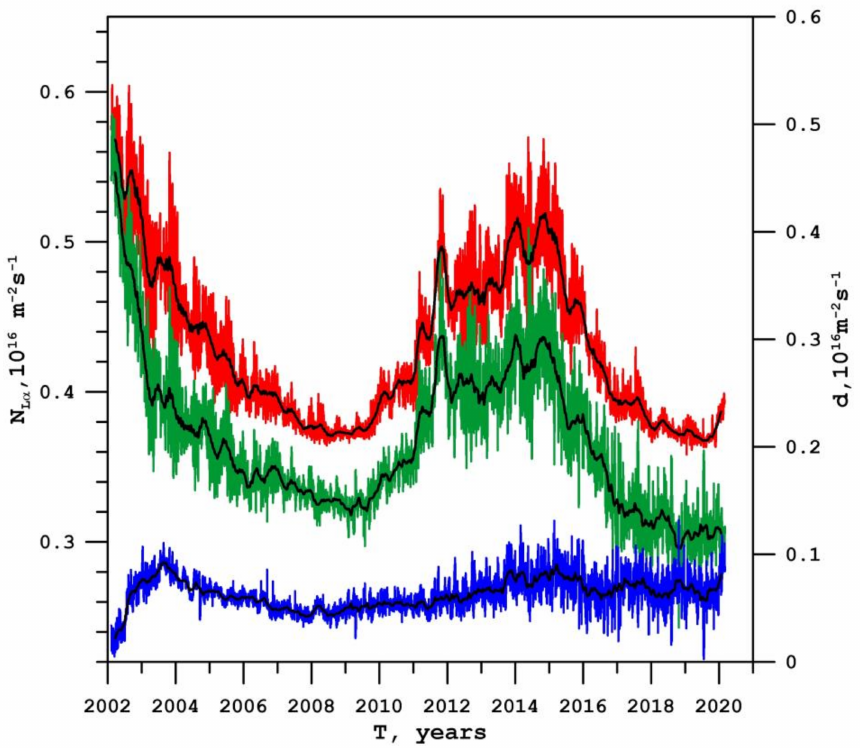
Figure 1. Changes in L α C ( red ) and L α T ( green ) in 23 and 24 cycles of activity. ( Blue )—difference d between data. Color lines correspond to daily data. Black lines represent 81-day moving